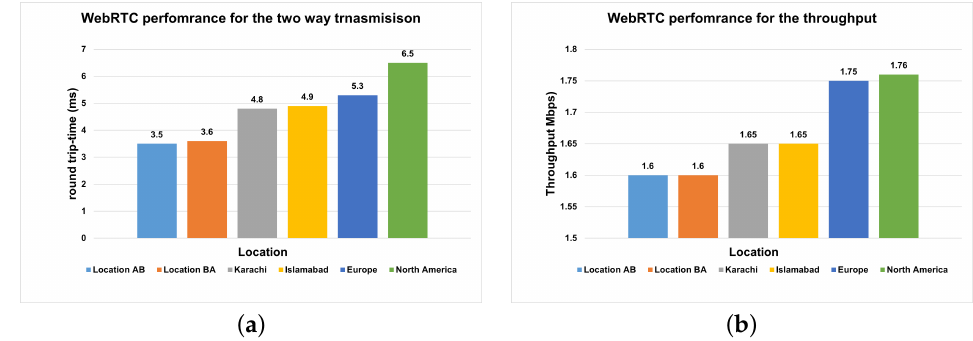
Figure 15. ( a ) Round transmission time (ms) for multiple locations; ( b ) throughput (kbps) with respect to multiple